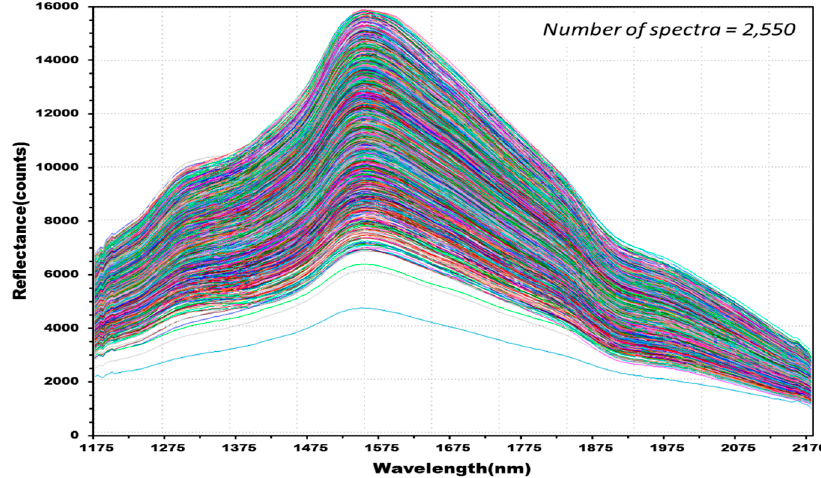
Figure 7. NIR reflectance spectra obtained from hulled barley samples (515 kernels) in both the control and experimental groups.